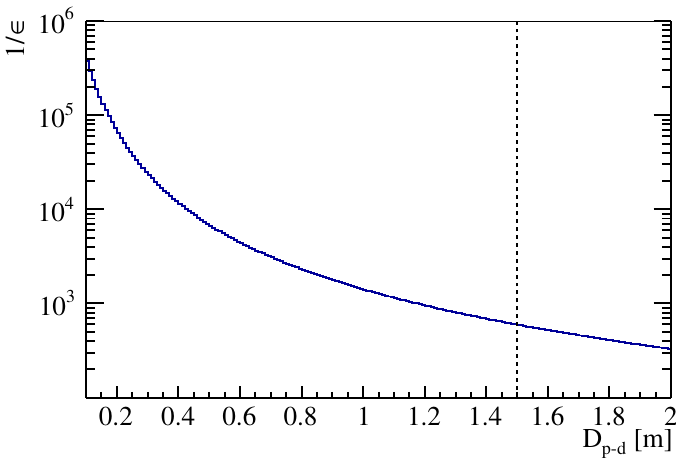
Figure 9. The integral distribution of the suppression factor (1/ (cid:15) ) as a function of the distance D for a time coincidence window ∆ T = 1 ms between the prompt and the delayed signals p − d p − d with energy in the ranges E = [0.7, 12] MeV and E = [1.9, 2.5] MeV, respectively. The default p d D range (i.e. D = [0, 1.5] m) is shown as the dashed p − d p − d